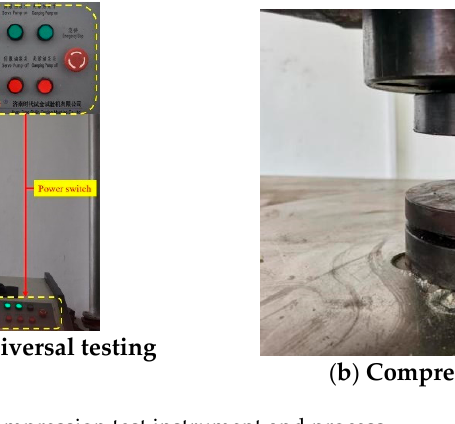
Figure 3. Compression test instrument and process.